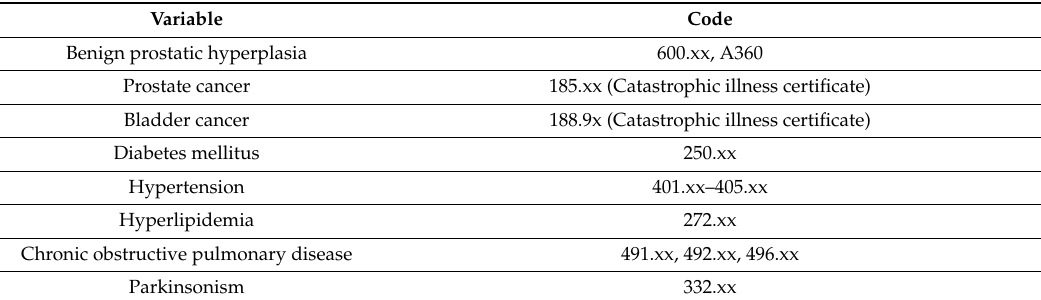
Table 1. ICD-9-CM codes used in the current